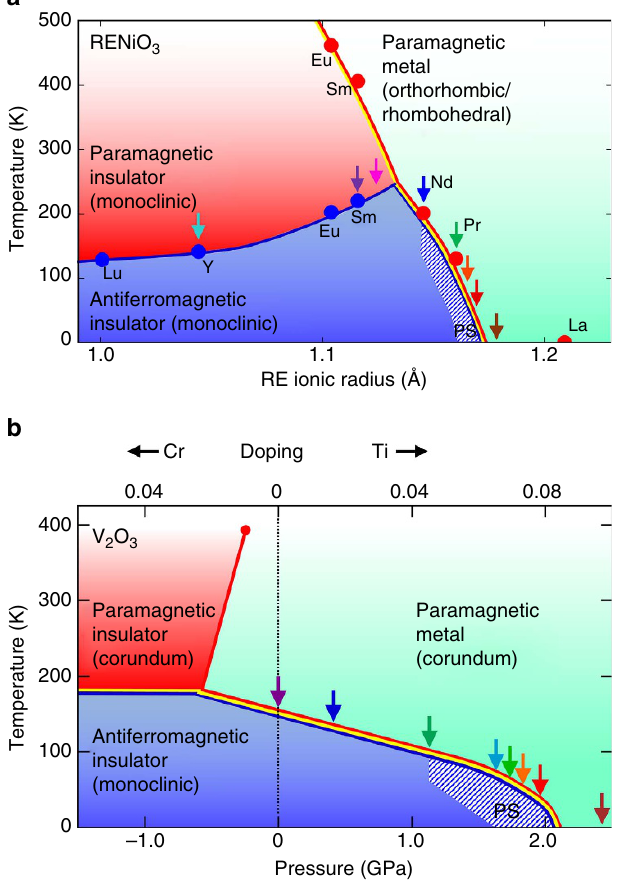
Figure 1 | Phase diagrams for canonical Mott systems RENiO 3 and V 2 O 3 . ( a ) RENiO 3 phase diagram, with temperature along the vertical axis and rare-earth ionic radius along the horizontal axis. The red curve indicates a metal–insulator transition on cooling, blue a paramagnet–antiferromagnetic transition, and yellow a structural transition. The coloured circles represent phase boundaries for the stoichiometric compounds determined by previous studies. Coloured arrows indicate compositions studied in the current work. The quantum phase transition (QPT) occurs at a radius of B 1.175Å. PS, phase separated. After ref. 4. ( b ) V 2 O 3 phase diagram, with temperature along the vertical axis and hydrostatic pressure along the horizontal axis. The QPToccurs at a pressure of B 2.0GPa. Doping with Ti and Cr is shown on the upper horizontal axis for comparison. All coloured curves and symbols are the same as in a . After ref.